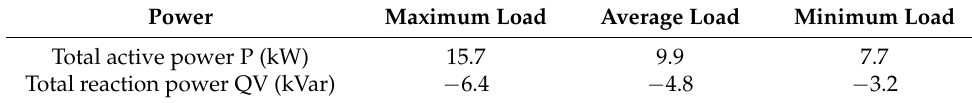
Table 3. Recorded total requirement for power of the monitored facility.